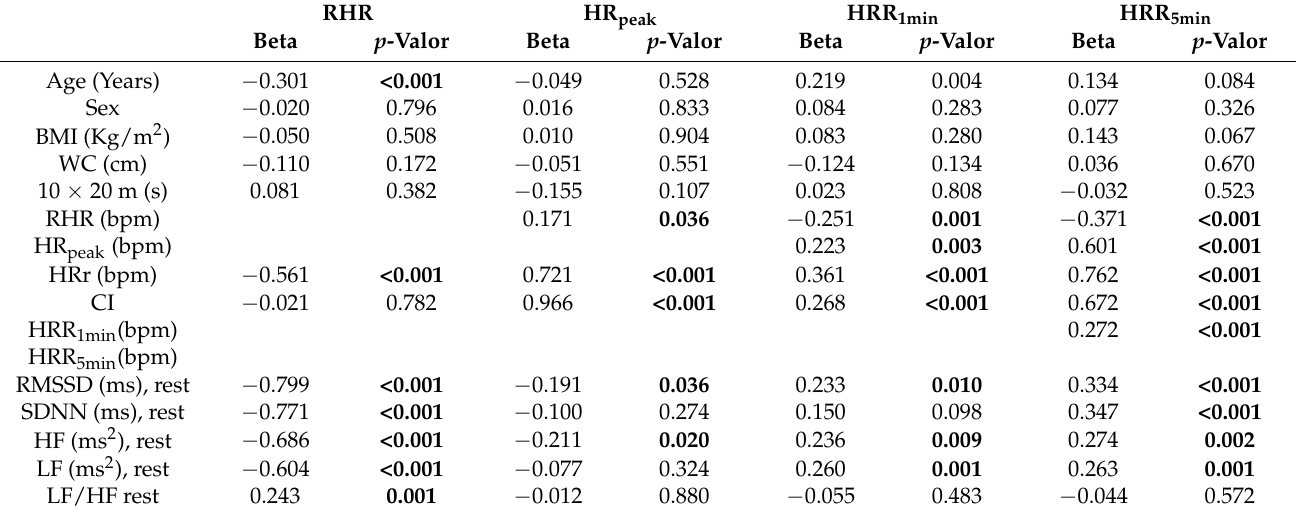
Table 2. Standardized beta coefficients from linear regression models for age, sex, anthropometric markers, performance in 10 × 20 m test, and HRV with cardiovascular autonomic function.